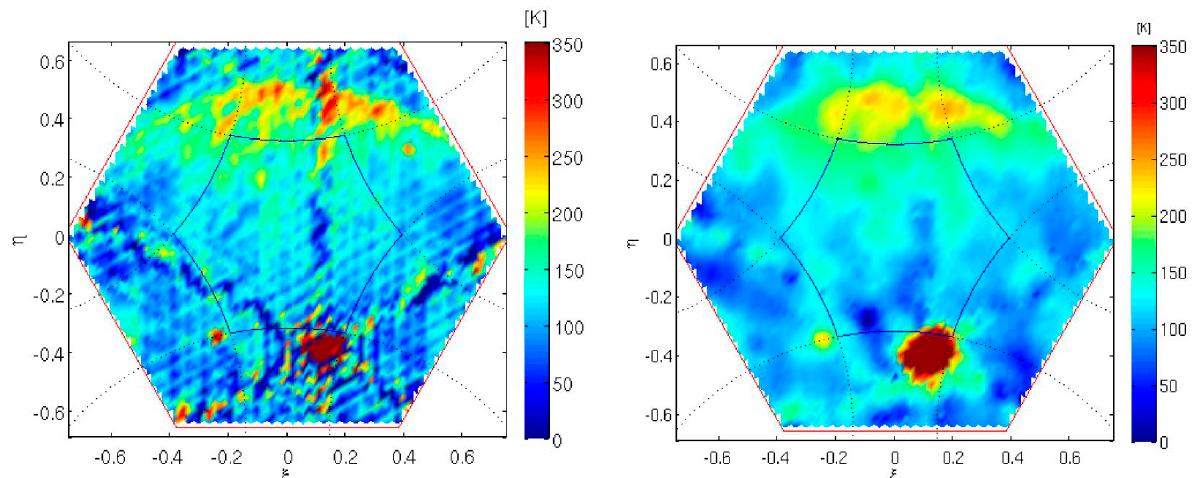
Fig. 1. – Brightness temperatures in the fundamental hexagon of a snapshot over the Atlantic Ocean strongly affected by an RFI (Radio Frequency Interference) produced by a ship, Y-polarization. Left, nominal TB; right, nodal sampling TB (Brightness Temperature). A clear reduction of the general ripples and the sidelobes along the RFI directions can be appreciated using the nodal sampling